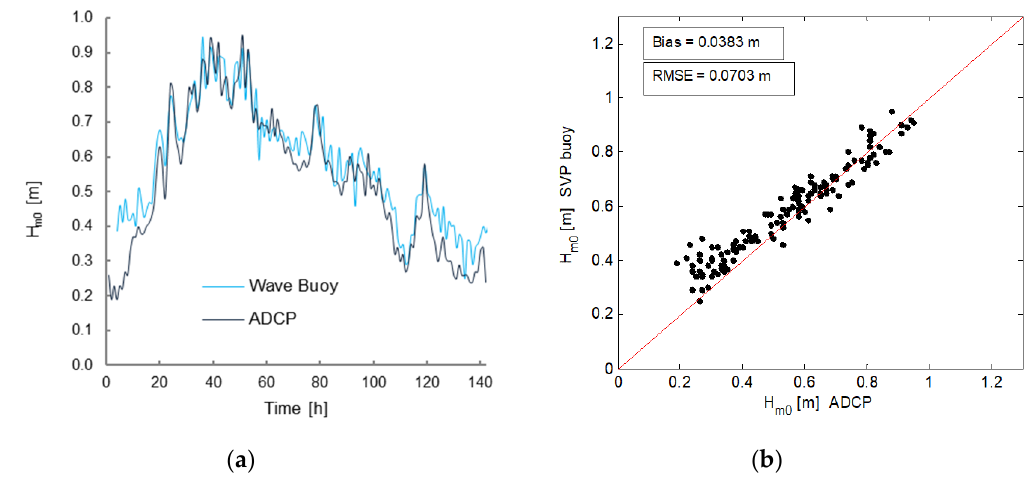
Figure 11. ( a ) Data series of the significant wave height H m0 between DWSD-B buoy and ADCP-B (from 12 May to 18 May 2016); ( b ) comparison of the significant wave height H m0 between the two instruments.